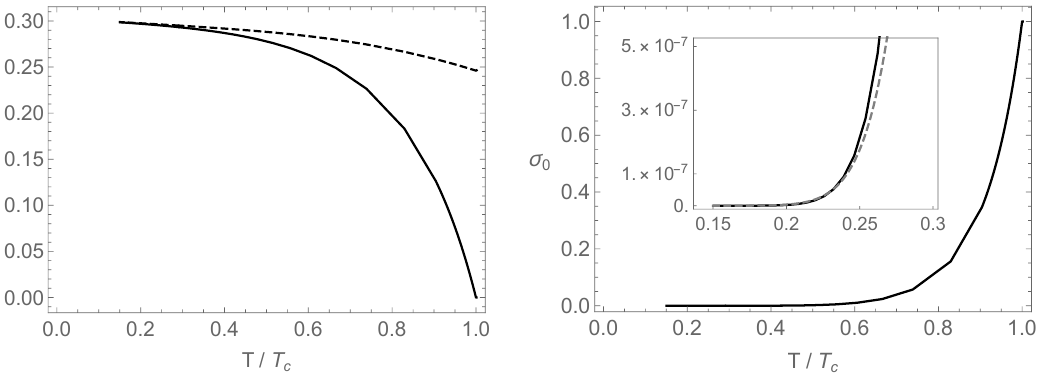
Figure 3 . Left: Total density ρ/µ 2 (dashed) and superfluid density ρ s /µ 2 (solid). The total density ρ is evaluated from eq. (3.9) while the superfluid density is from the optical conductivity data. Right: σ 0 as a function of the reduced temperature. The inset shows the low temperature behavior: numerical result (solid black), fitting result (4.4) (dashed